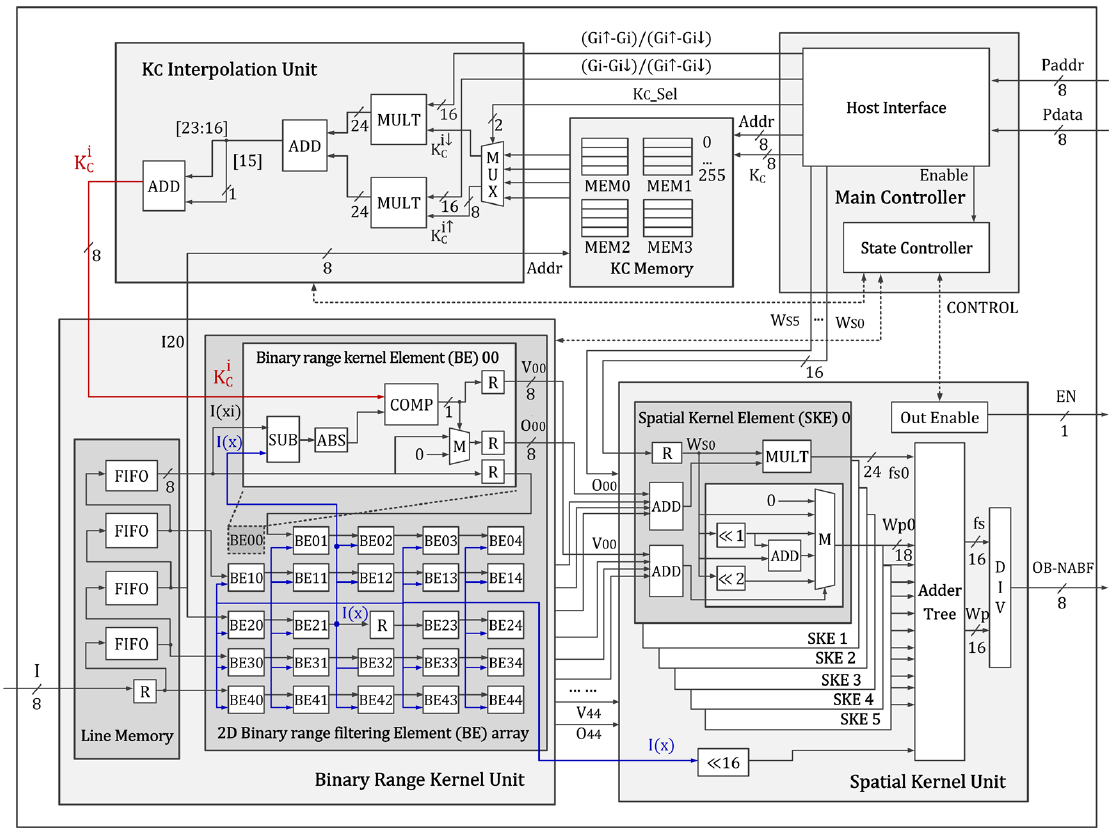
Figure 3. Proposed VLSI architecture of noise-aware bilateral filter. Here, R denotes registers; ADD and SUB denote adders and subtractors, respectively; MULT and DIV are multipliers and the divider, respectively; M and MUX are multiplexers; and ABS and COMP are the logic to conduct absolute operation and comparison,